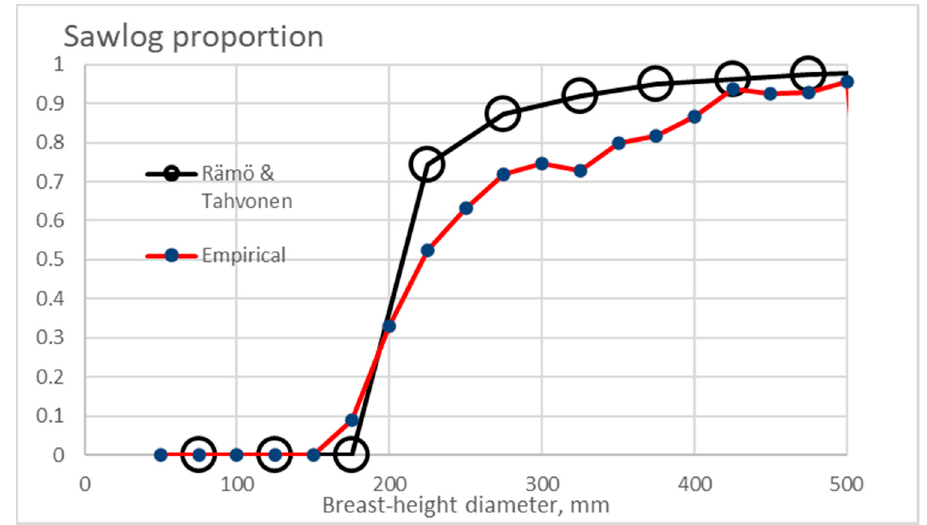
Figure 1. Literature values, as well as empirical values of sawlog proportion within the commercial section of spruce stems of different sizes.